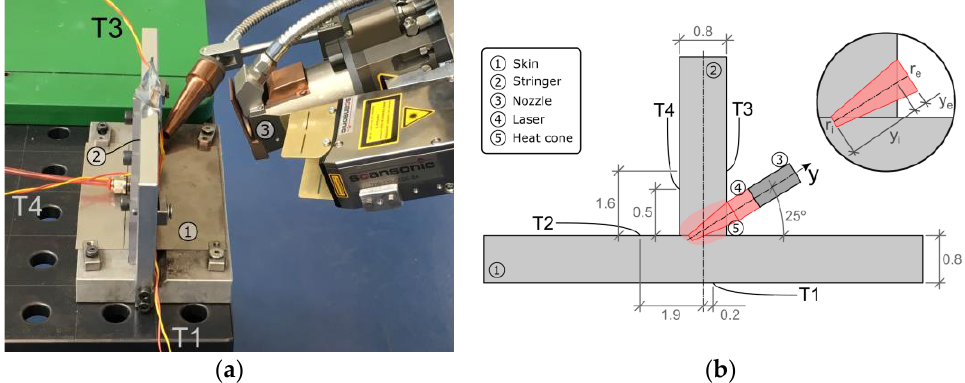
Figure 2. Welded sample: ( a ) Photo of the specimen with the thermocouples during welding and ( b ) Sketch of the T-joint with location of thermocouples.